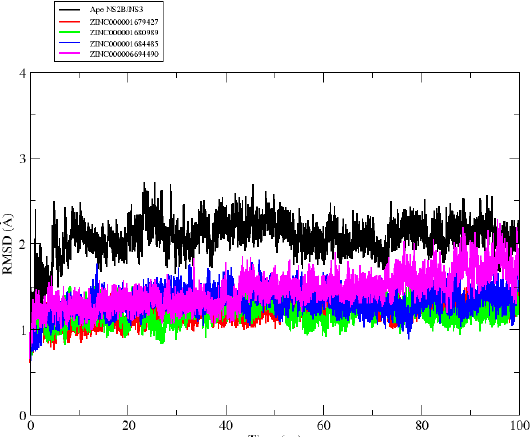
Figure 2. . Graphical representation of the RMSD values versus the simulation time to the backbone Apo NS2B/NS3 (black line) ZINC000001679427 (red line), ZINC000001680989 (green line), ZINC000001684485 (blue line) and ZINC000006694490 (magenta line) studied.